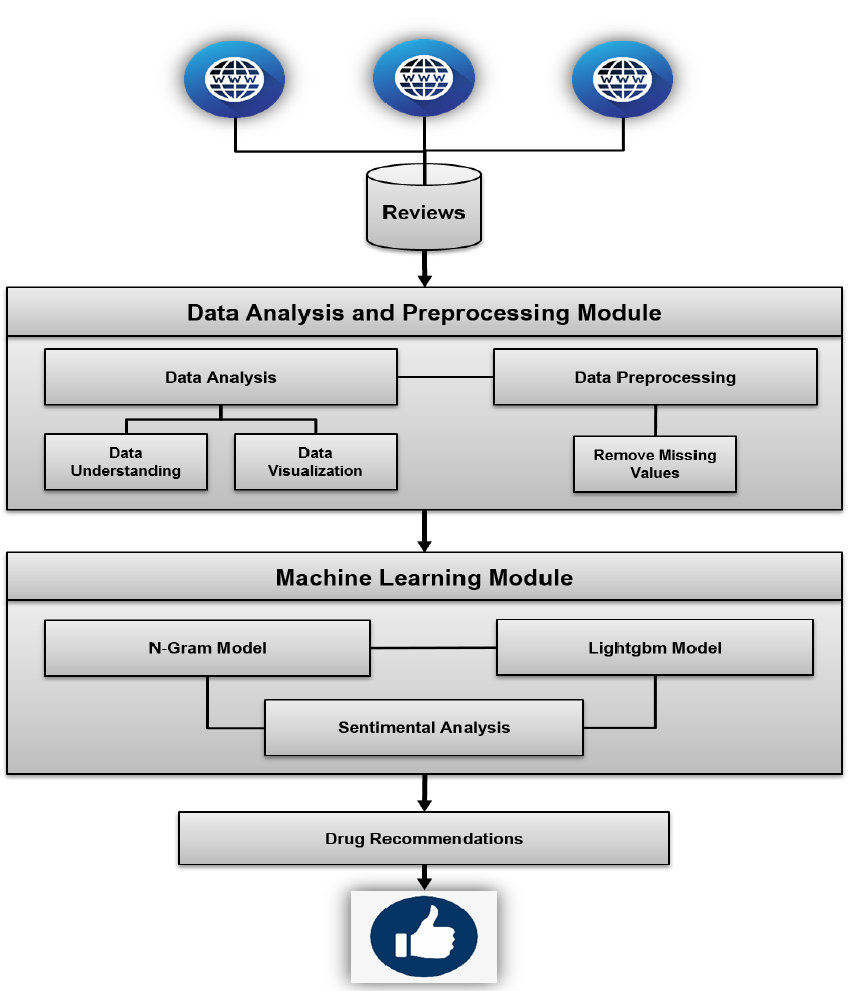
Figure 5. Architecture of machine learning based drug recommendation